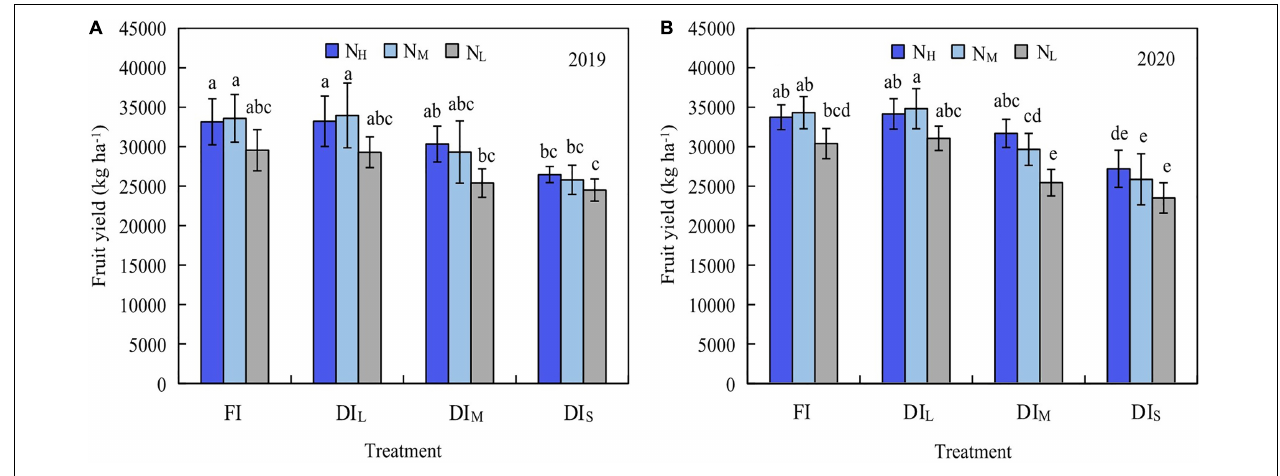
FIGURE 4 | Effects of water and nitrogen coupling on yield of mountain apple in 2019 (A) and 2020 (B) . Different letters above the bars indicate a significant difference at P < 0.05 according to the Duncan test. FI, DI L , DI M , and DI S are full irrigation, light deficit irrigation, moderate deficit irrigation, and severe deficit irrigation, respectively. N H , N M , and N L are high nitrogen, medium nitrogen, and low nitrogen, respectively. Bars and errors stand to represent mean ± SD.